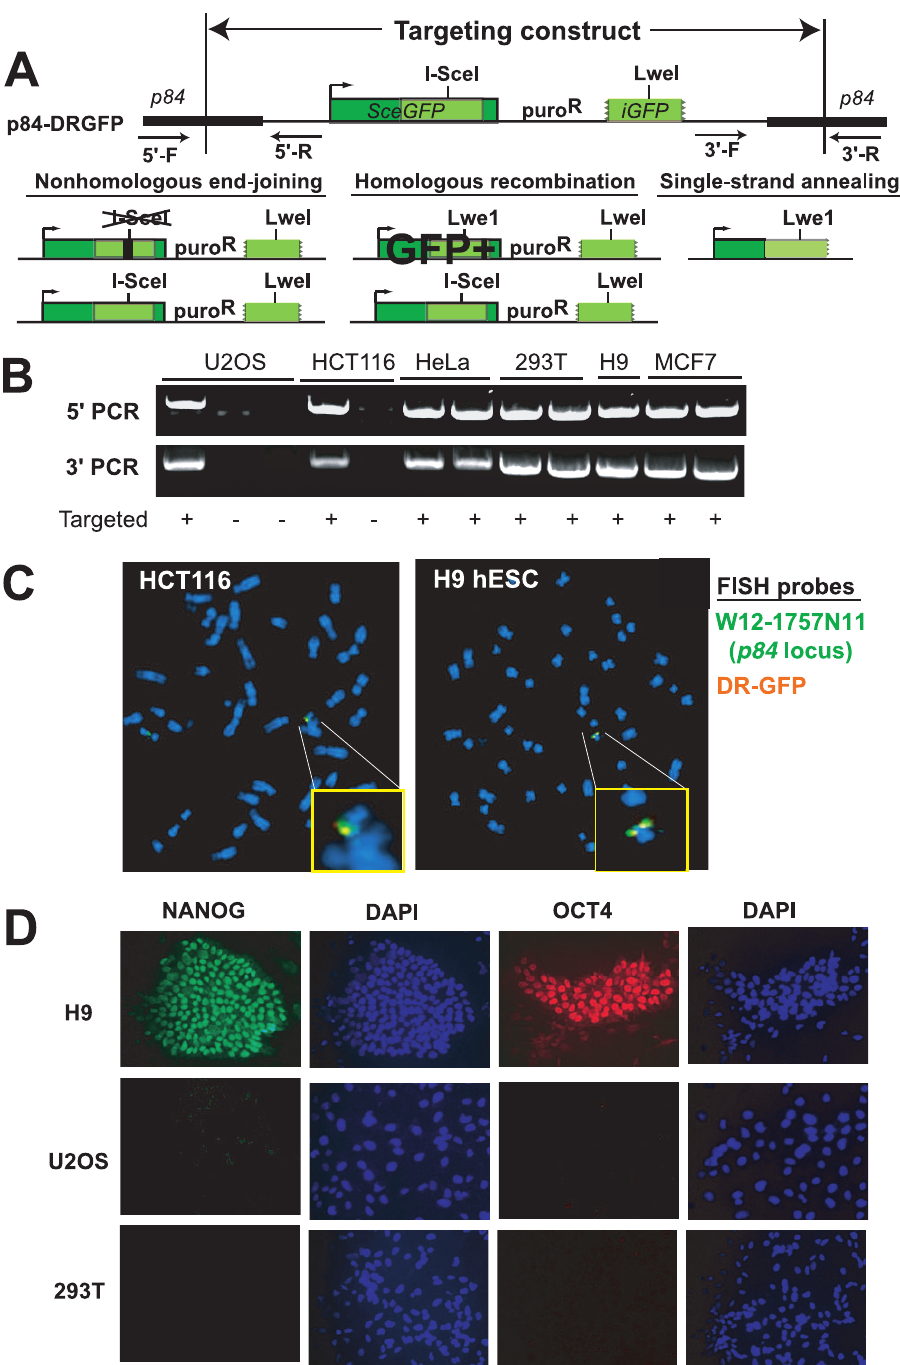
Figure 1. Targeting of p84-DR-GFP. A . A DSB formed by I-SceI within the SceGFP gene in p84-DR-GFP can either be repaired by nonhomologous end-joining, homologous recombination or single-strand annealing. HR using the iGFP template establishes a functional GFP . Precise NHEJ or HR using the SceGFP on the sister chromatid as a template can reestablish the I-SceI site. Arrows indicate primers for confirming targeting to p84 . B . PCR demonstrates targeting at the 5 9 and 3 9 borders of p84 - DRGFP. C . FISH demonstrates overlap of the p84 locus (green) and DR-GFP (orange) probes indicating targeting of DRGFP to the p84 locus in hESCs and HCT116 cells. Insets are magnified images of the indicated regions. D . Immunofluorescence microscopy for pluripotency markers in H9 hESCs, U20S and 293T cells. similar expression in hESCs and somatic cell lines at multiple time points after transduction (Figure 3C).